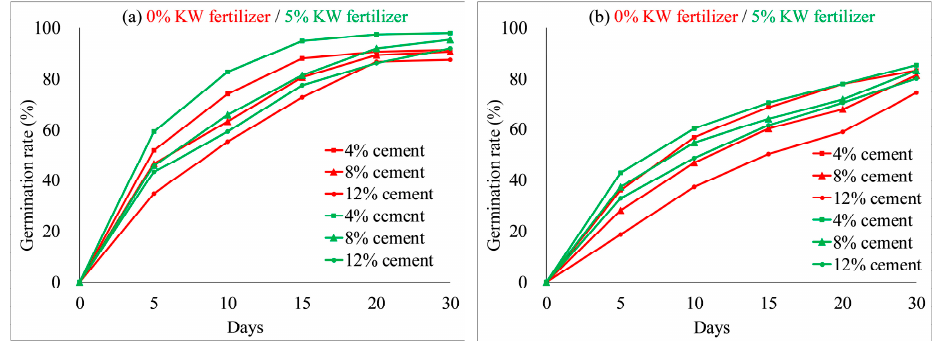
Figure 6. Seed germination rates related to different percentages of cement: ( a ) Ryegrass ; ( b ) Festuca elata .